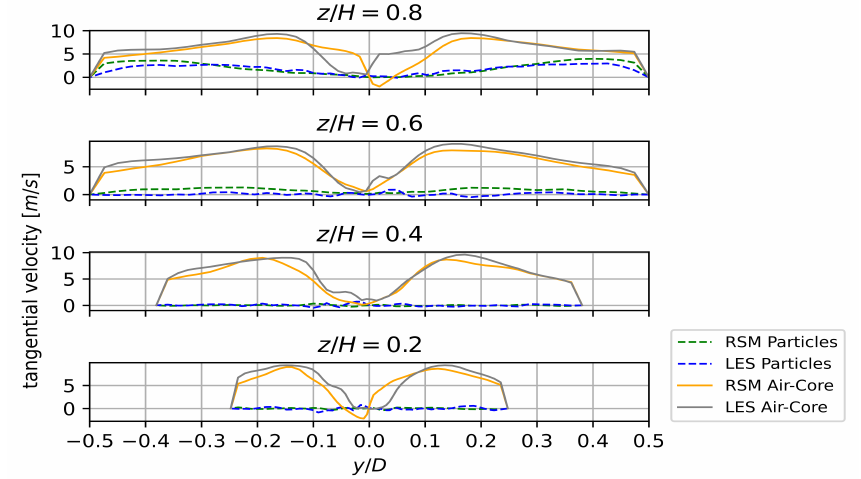
Figure 14. Tangential velocities (m/s) as a function of the normalised y co-ordinate at various heights at flow-time 4 s for the simulations with the particles included and at flow-time 2 s for the air-core only simulations.